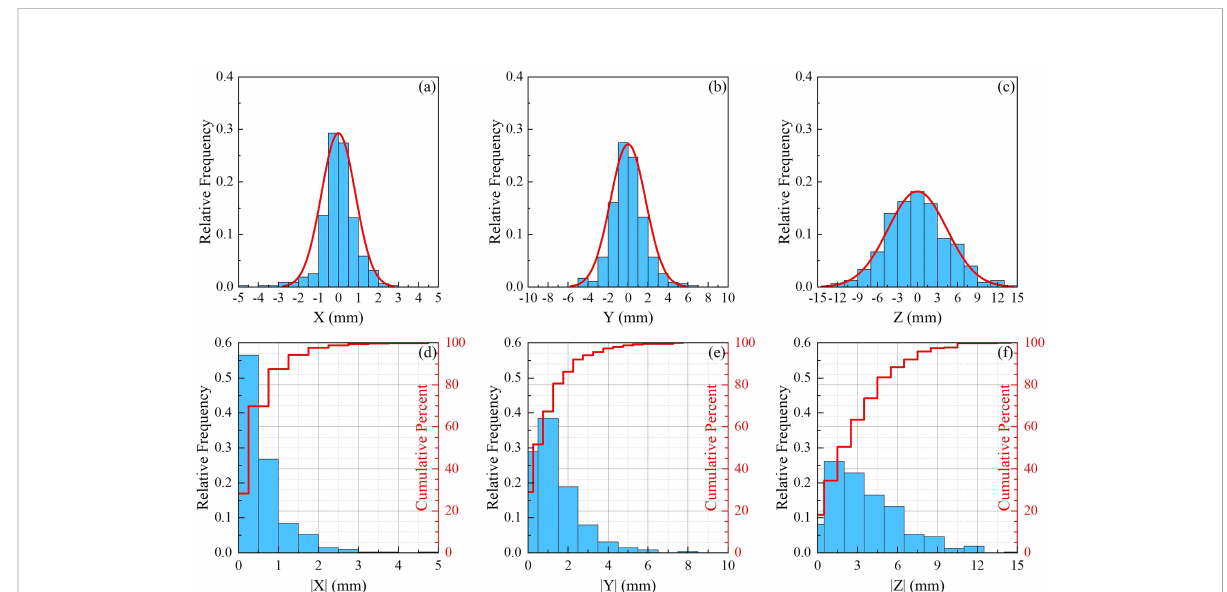
FIGURE 2 Statistics for translational movements. (A – C) are normalized frequency histograms of translational movements in the LR ( X ), AP ( Y ) and SI ( Z ) axes, respectively. The red curves are a Gaussian function fi tting for the histograms. (D – F) are normalized histograms (blue bars) and cumulative percent distribution (red histograms) with different absolute motion magnitudes for LR, AP and SI directions.